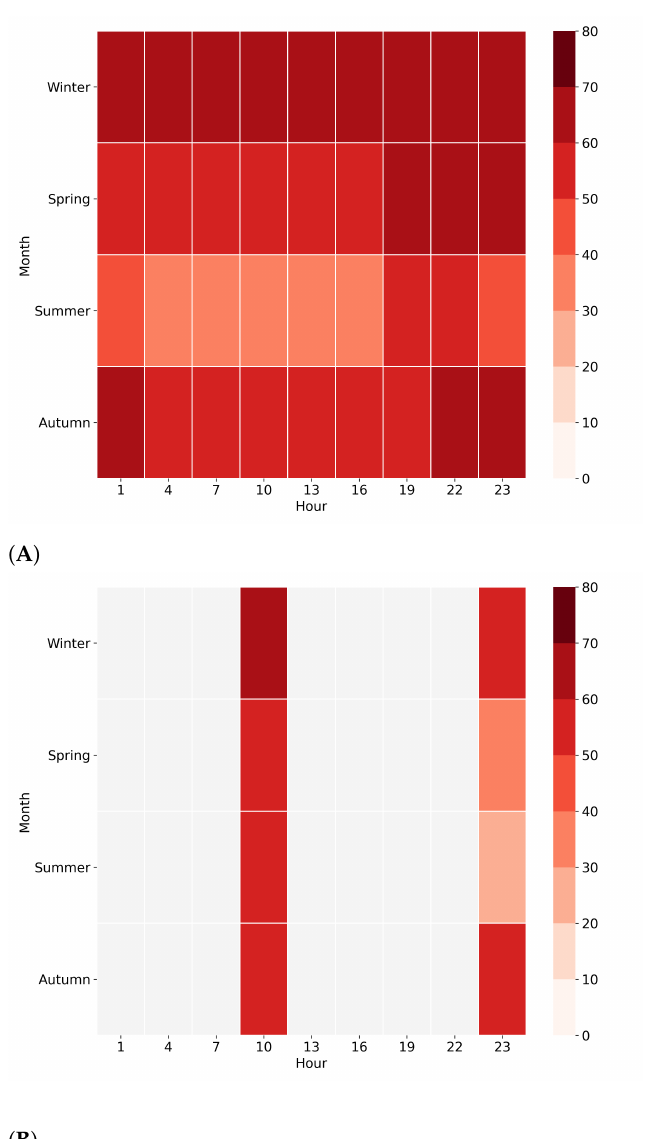
Figure 12. Seasonality and diurnal characteristics of power output capacity in percent. Power output capacity are averaged by month and hour. ( A ) Merged data. Approximate observations per cell: